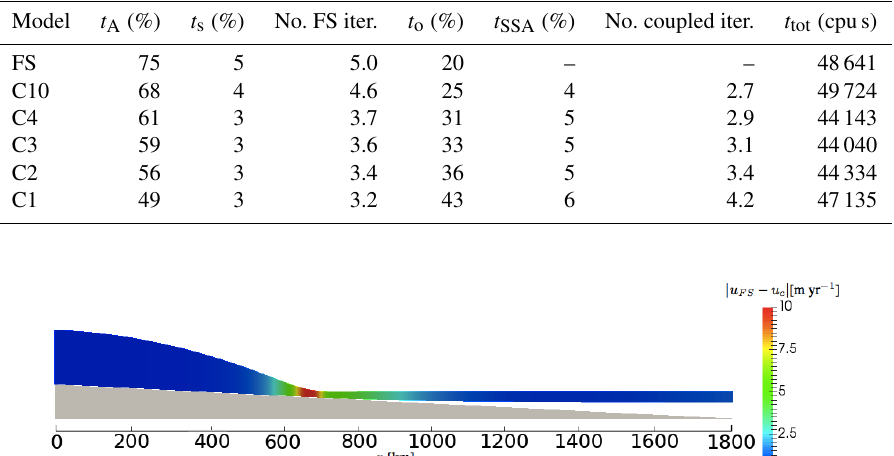
Table 1. Computation times for the MIS simulation of 3000 years with FS-only and the coupled model. Model C i denotes the coupled model, with i being the maximum number of nonlinear FS iterations per coupled iteration; C5–C9 are omitted for brevity. The assembly time for A FS is denoted as t A . All relative computation times are given in percentage of the total time t tot . The number of FS and coupled iterations are averaged over the time steps.